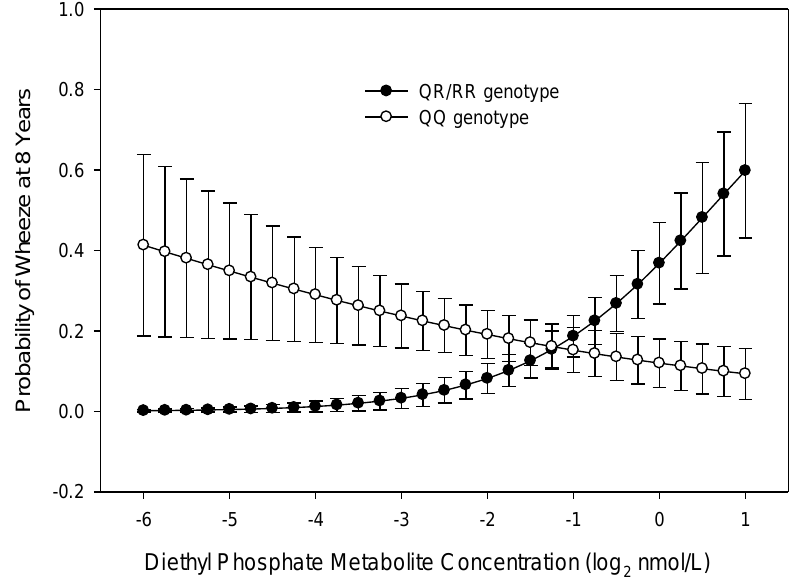
Figure 4. Probability of child wheeze at age 8 years related to maternal PON1 192 genotype and maternal diethyl phosphate (DE) metabolite concentration during gestation among white mothers ( n = 110).